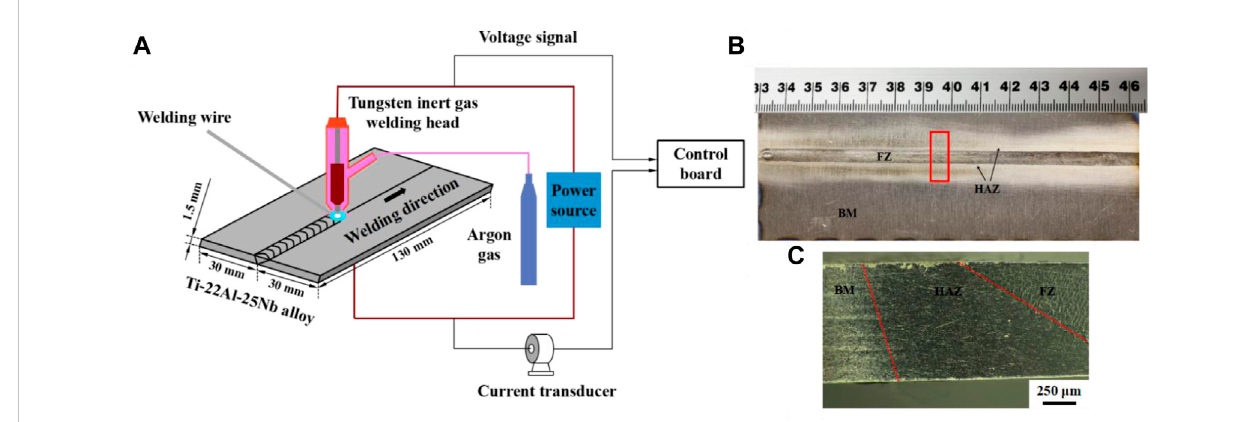
FIGURE 1 Welding of Ti-22Al-25Nb alloy: (A) schematic illustration of the experimental setup; (B) weld seam appearance of the weld joint of Ti-22Al-25Nb alloy; (C) weld joint includes three different zones: fusion zone (FZ), heat-affected zone (HAZ), and base material